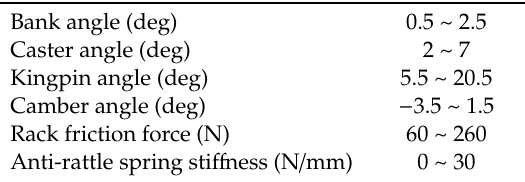
Table 3. Variation of steering pull parameters.